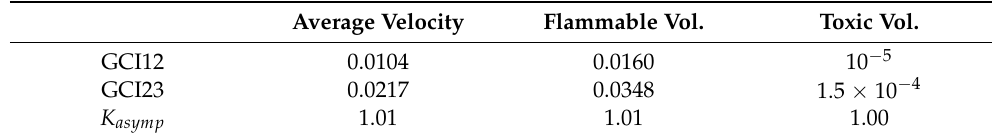
Table A2. Grid Convergence Index for the dispersion